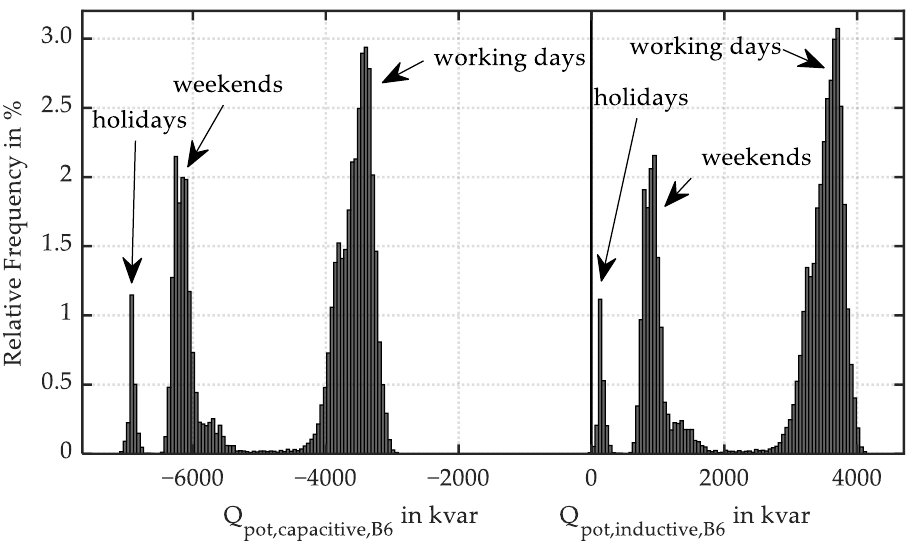
Figure 4. Relative frequency of the capacitive and inductive reactive power potential of B6.